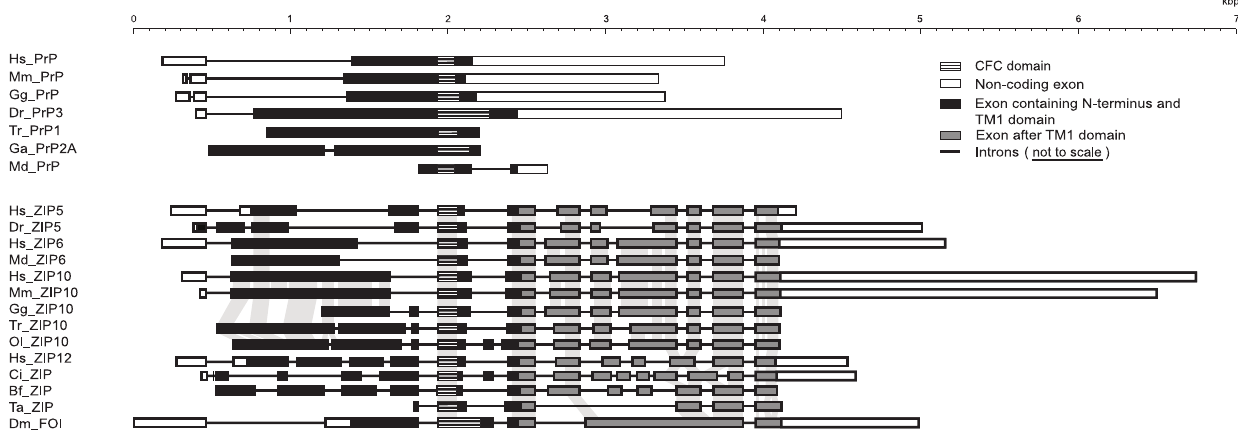
Figure 3. Multiple introns observed in the coding regions of ZIP genes are missing from prion genes. Complex intron/exon arrangements of ZIP genes contrast the genomic organization of prion genes characterized by a coding sequence that is confined to one or, in rare instances, two exons. Only exons are depicted to scale. Black, hatched, grey or white fillings depict exons coding for the ectodomain, the cysteine- flanked core (CFC), the C-terminal multi-spanning transmembrane domain of ZIP transporters or non-coding segments of a given transcript, respectively. The black solid lines connecting exon boxes indicate introns. Untranslated regions (UTRs) are not depicted for a subset of sequences lacking reliable relevant annotation in the databases. For Tr_PrP1, part of the 5 9 UTR, the ORF and the 3 9 UTR are encoded in a single exon. Dm_FOI represents the ZIP ortholog in D. melanogaster with strong sequence similarity to mammalian ZIPs 5, 6 and 10. kbp, kilobase pairs.